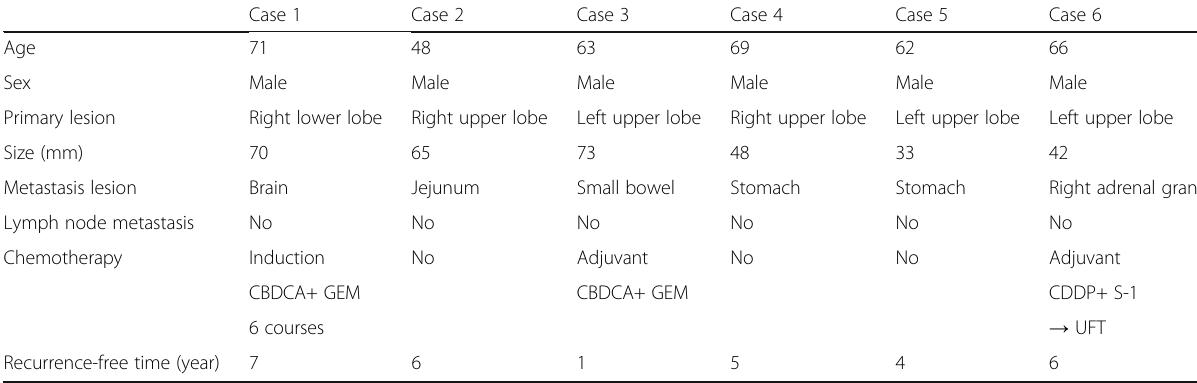
Table 1 The features of stage IV pleomorphic carcinoma cases getting long-term survival after